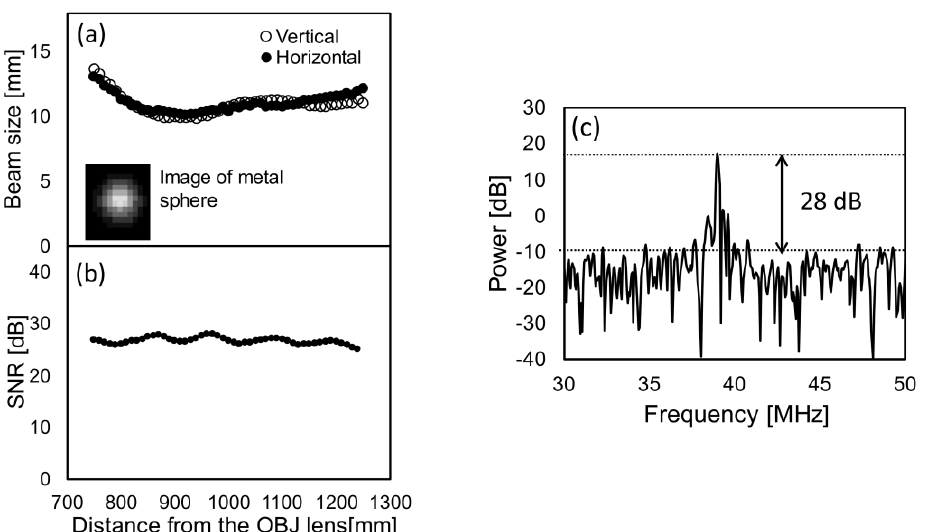
Figure 12. ( a ) Detection of spot size and ( b ) sensitivity variation with the optical direction. ( c ) Power spectra of a radar signal from a metal sphere located near focus.